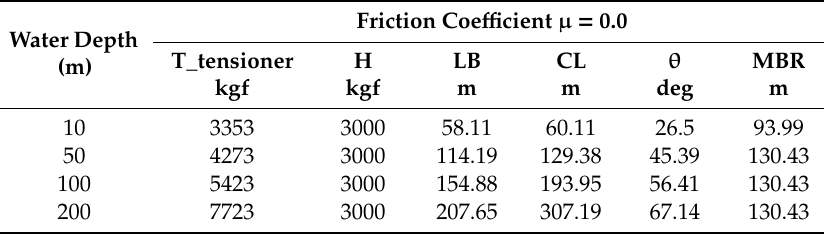
Table 8. Cable critical responses assuming friction coe ffi cient µ = 0.0.